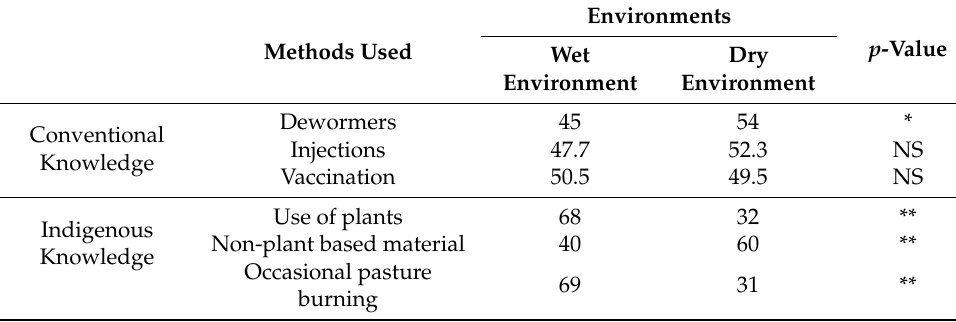
Table 2. Measures used to control gastrointestinal